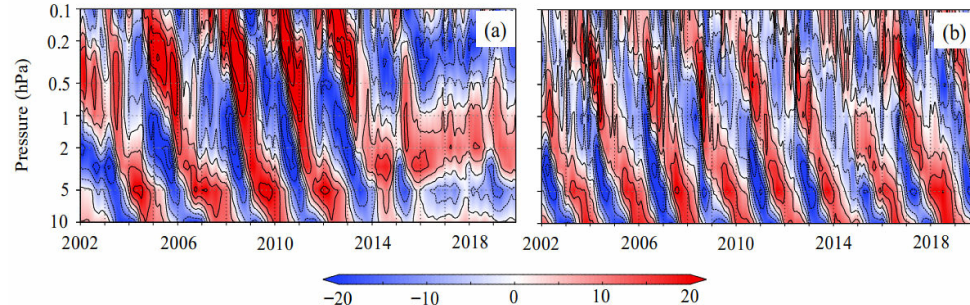
Figure 9. Time–height cross-sections of zonal–mean-zonal wind anomalies (ms − 1 ) averaged between 10 ◦ S and 10 ◦ N in the tropical upper stratosphere and mesosphere (10–0.1 hPa) for ( a ) the perpetual runs of ( a ) April and ( b ) October. Contours interval is 7 ms − 1